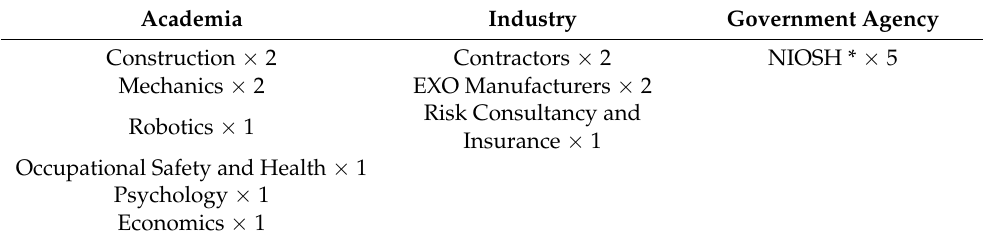
Table 1. Composition of the expert